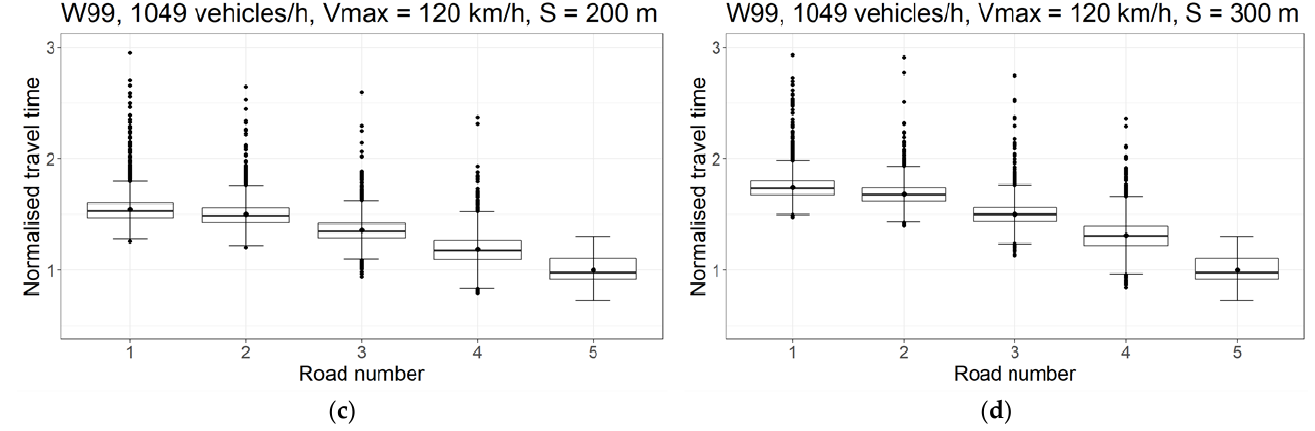
Figure 5. Normalised travel time, depending on traffic volume and road signs distance. ( a ) Road G: L = 1 km, TL = 600 m; ( b ) Road GP: L = 1 km, TL = 600 m; ( c ) Road S: L = 2 km, TL = 1600 m; ( d ) Road S: L = 2 km, TL = 1600 m.